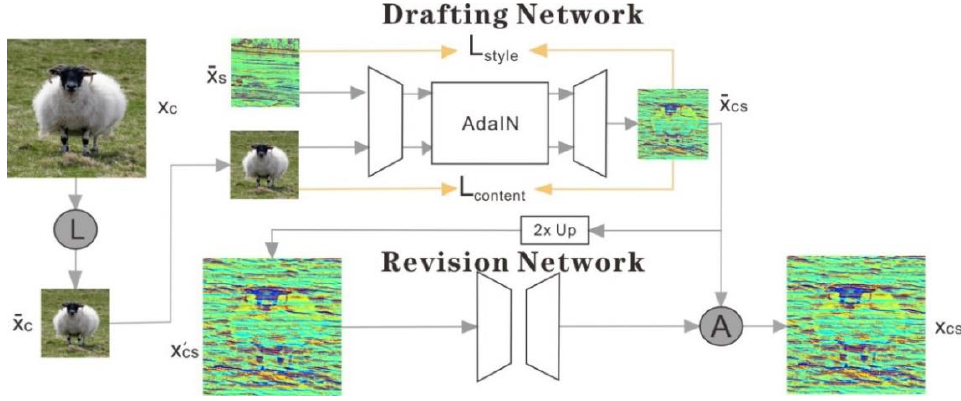
Figure 3. Network structure of Laplacian pyramid network [29]. Firstly, the content image is reduced by two times, and L, C and A in the image separately represent Laplacian concatenation and aggregation operations. At this time, the predefined style image is also reduced by two times − − to a low resolution version x s . In the drafting network stage, the content image x c and the style − image x s after double down-sampling are generated through a encoder-decoder AdaIN module to − generate a global but not detailed stylized image x cs . In the revision stage of the network, twice the (cid:48) − up-sampling processing x cs and connecting with the residual detail image as the input, the stylized residual detail image is generated through a encoder-decoder module. Finally, we aggregate the two-level image pyramid and output the final stylized image x cs